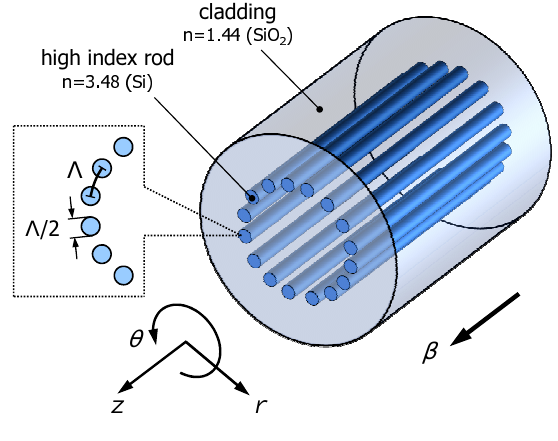
Figure 1. Refractive index profile of a sample fiber structure. (cid:3) denotes the period of the solid